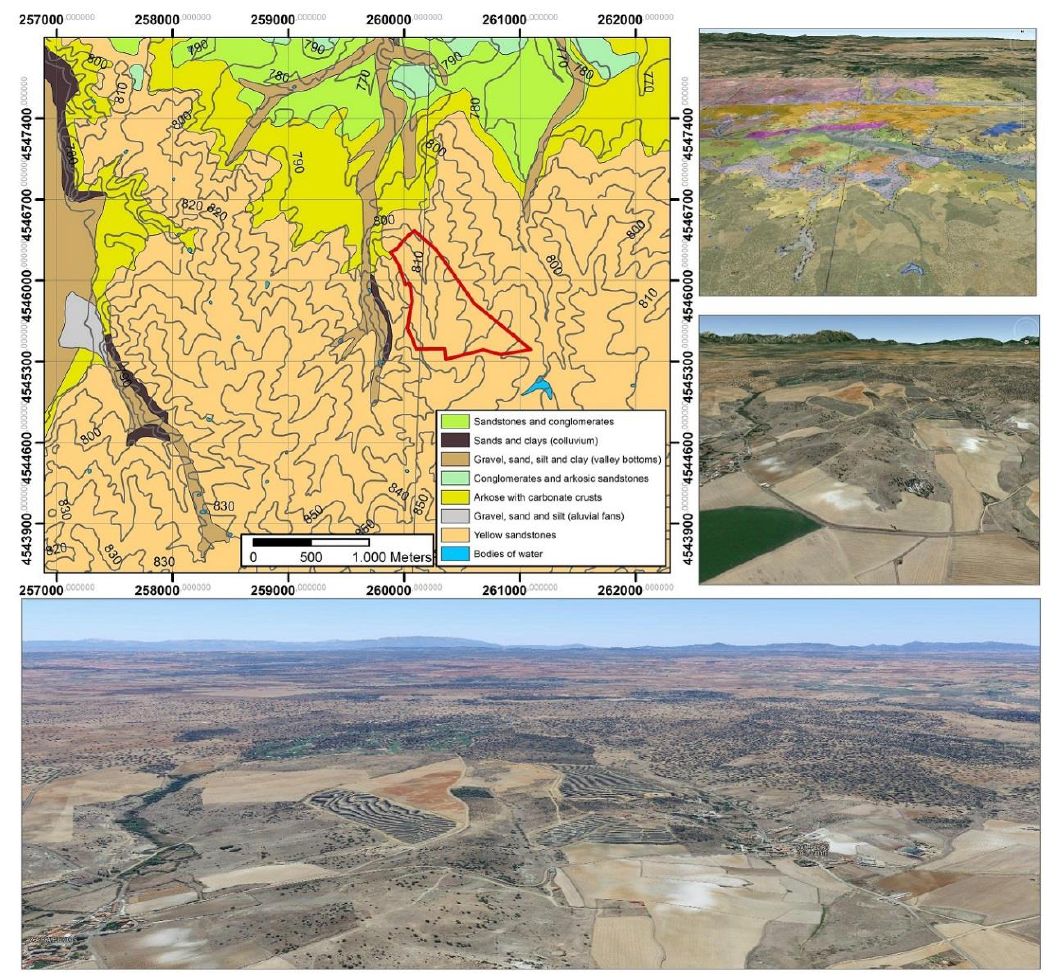
Figure 2. Lithological distribution in the study area and relief in Google Earth.